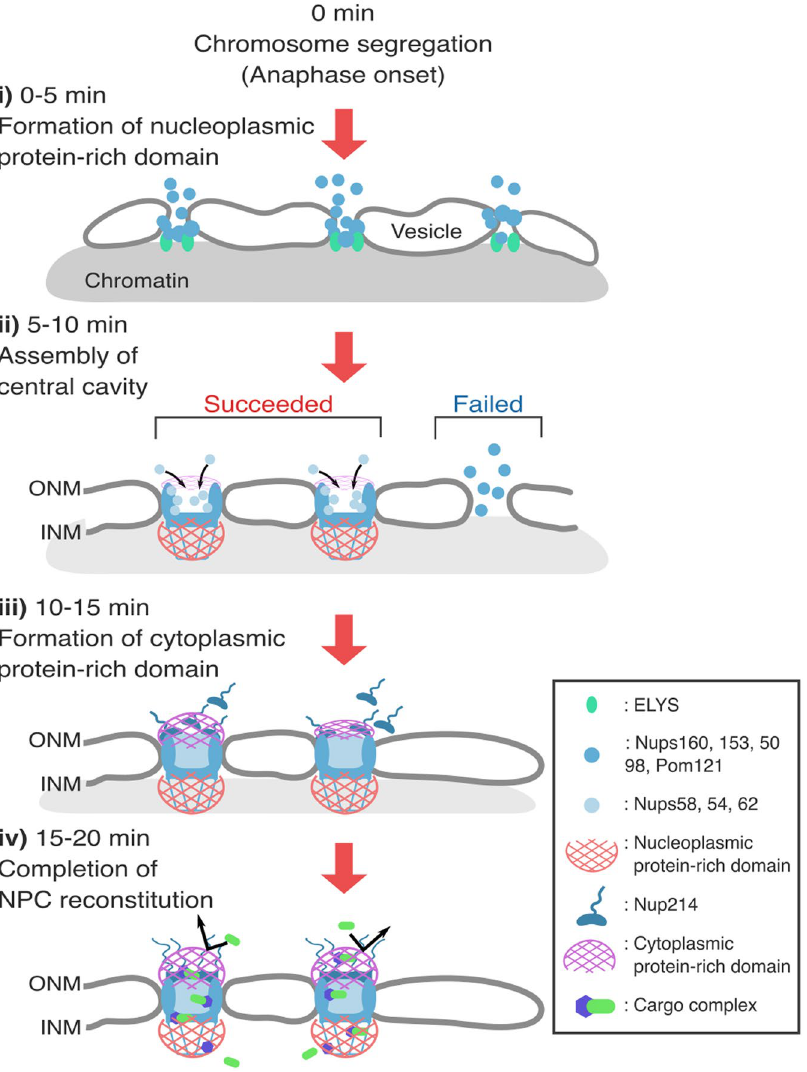
Figure 7. Schematic illustrations of the protein-rich domains during post-mitotic NPC reconstitution process. Schematic model of the post-mitotic reassembly process of the NPC. i) NPC reconstitution starts around 0–5 min after the onset of anaphase. After the initial binding of ELYS to the chromosome, scaffold and nucleoplasmic Nups start to assemble 60, 61 , and immediately form the nucleoplasmic protein-rich domain (red). ii) When it is properly assembled, it recruits Nups in the central cavity. There are also a significant number of miss-assembled complexes, which will dissociate from the chromosome surface and diffuse into the cytoplasm before assembling the central cavity Nups. iii) Following the assembly of the central cavity, the cytoplasmic Nups bind to the complex, and immediately form the cytoplasmic protein-rich domain. Nup98, which localizes to both ends of the pore, might also contribute to the formation of the cytoplasmic protein-rich phase (not shown here). iv) After 15–20 min, the reconstitution of the entire NPC with two distinct protein-rich phases is completed. INM: inner nuclear membrane; ONM: outer nuclear